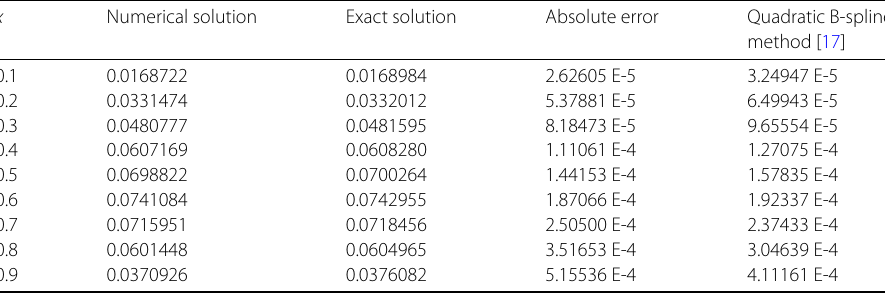
Table 6 The numerical results for the test problem at z = y = 0.5, x , y , z ∈ [0,1] x Numerical